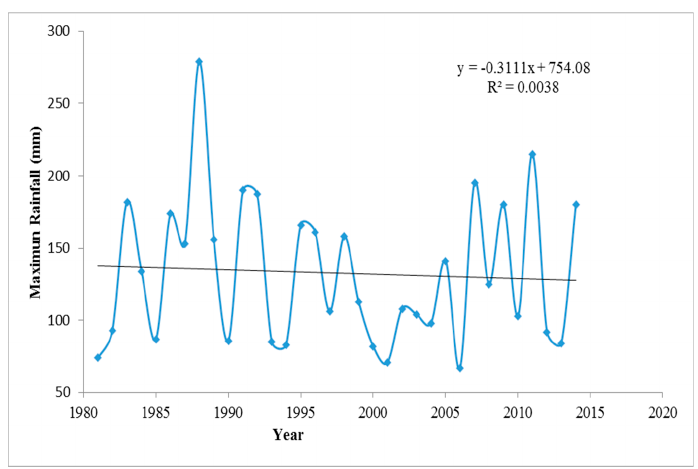
Figure 5. Trend of total maximum rainfall (mm) of Bogra station (1981–2015). Climate 2016 , 4 , 52